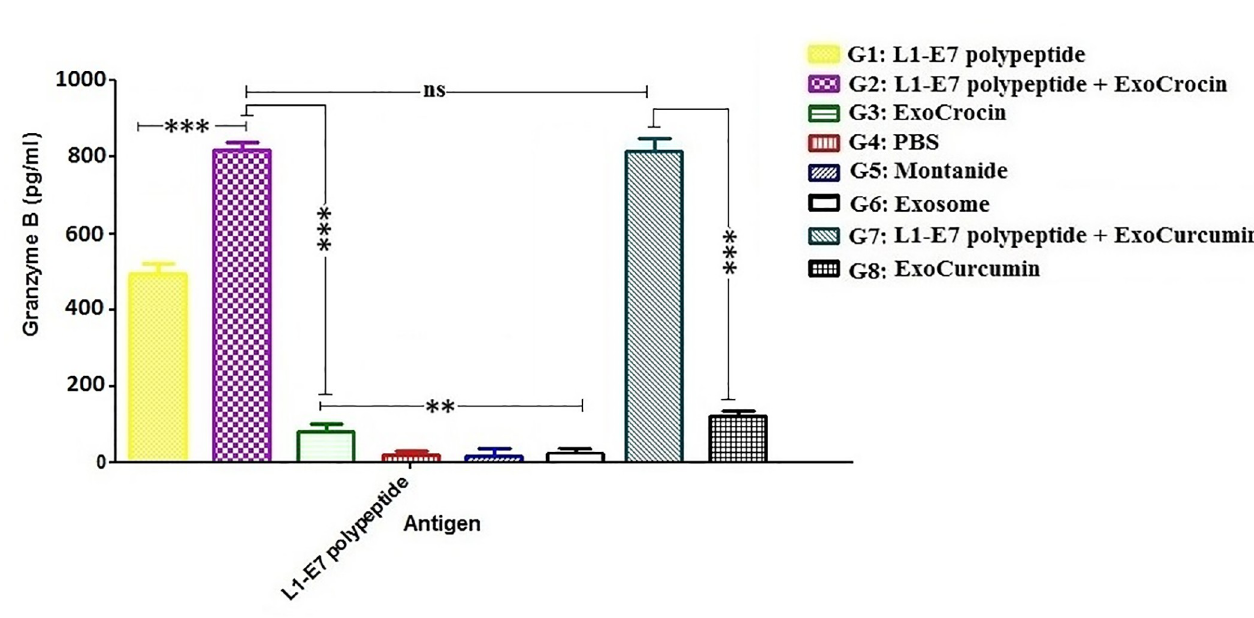
Fig 8. Evaluation of granzyme B secretion using ELISA. All analyses were performed in triplicate for each sample; ns: non-significant; � p < 0.05; �� p < 0.01; ��� p <